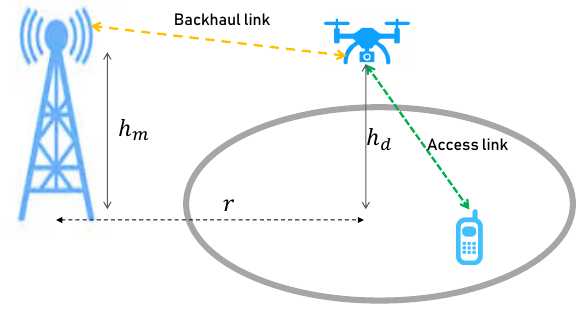
Figure 1. A two-hop communication system